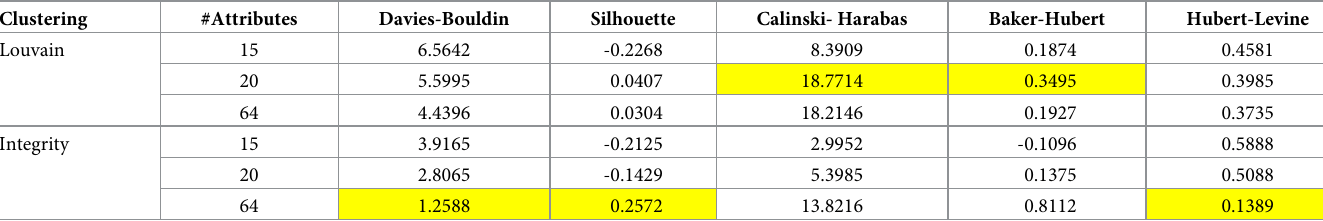
Table 2. Example of evaluation scores and methodology (Actual scores for the CT graphs). Best scores are highlighted in yellow.